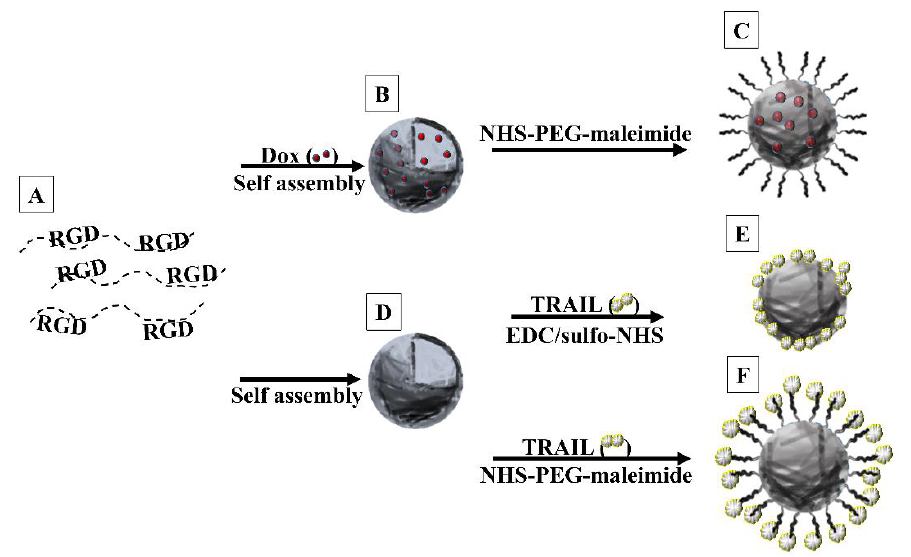
Figure 1. Scheme illustrating formation of various P(RGD) NCs. ( A ) RGD proteinoid polymers were self-assembled ( B ) with Dox and subsequently ( C ) PEGylated, or ( D ) without Dox and conjugated to TRAIL either ( E ) directly or ( F ) indirectly via PEG (3500 MW).